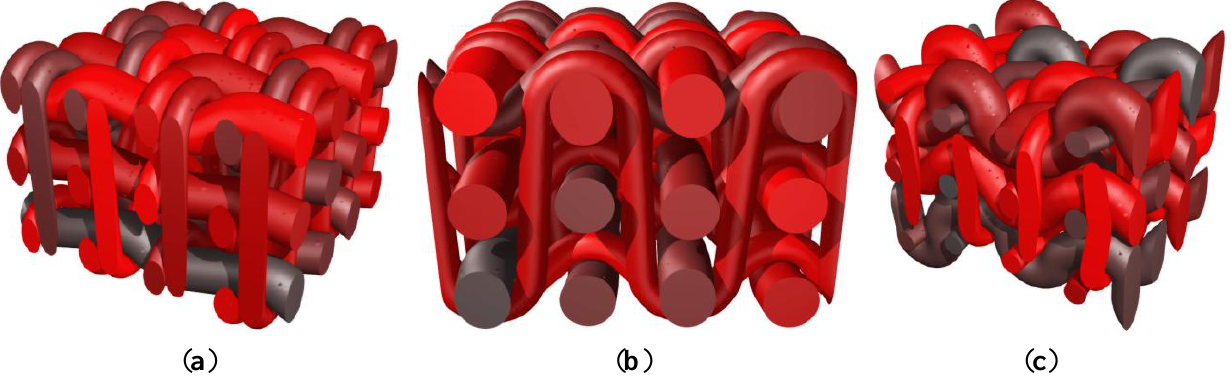
= 0.3)—axonometric view; ( b ) normally weft = 0.8). weft